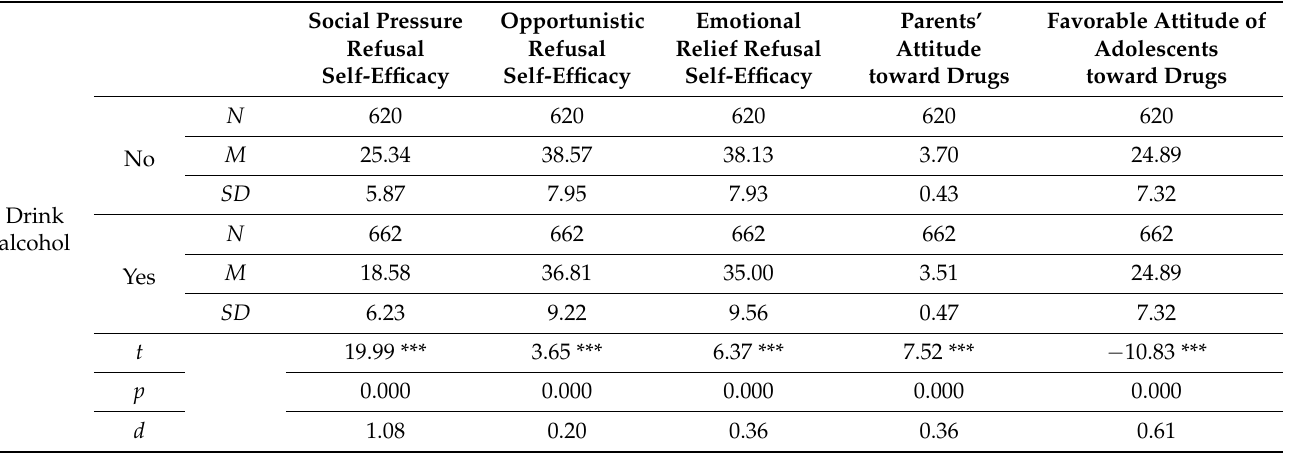
Table 4. Self-efficacy in refusing alcohol and attitudes toward drugs. Student’s t-test depending on consumption of alcohol or its absence